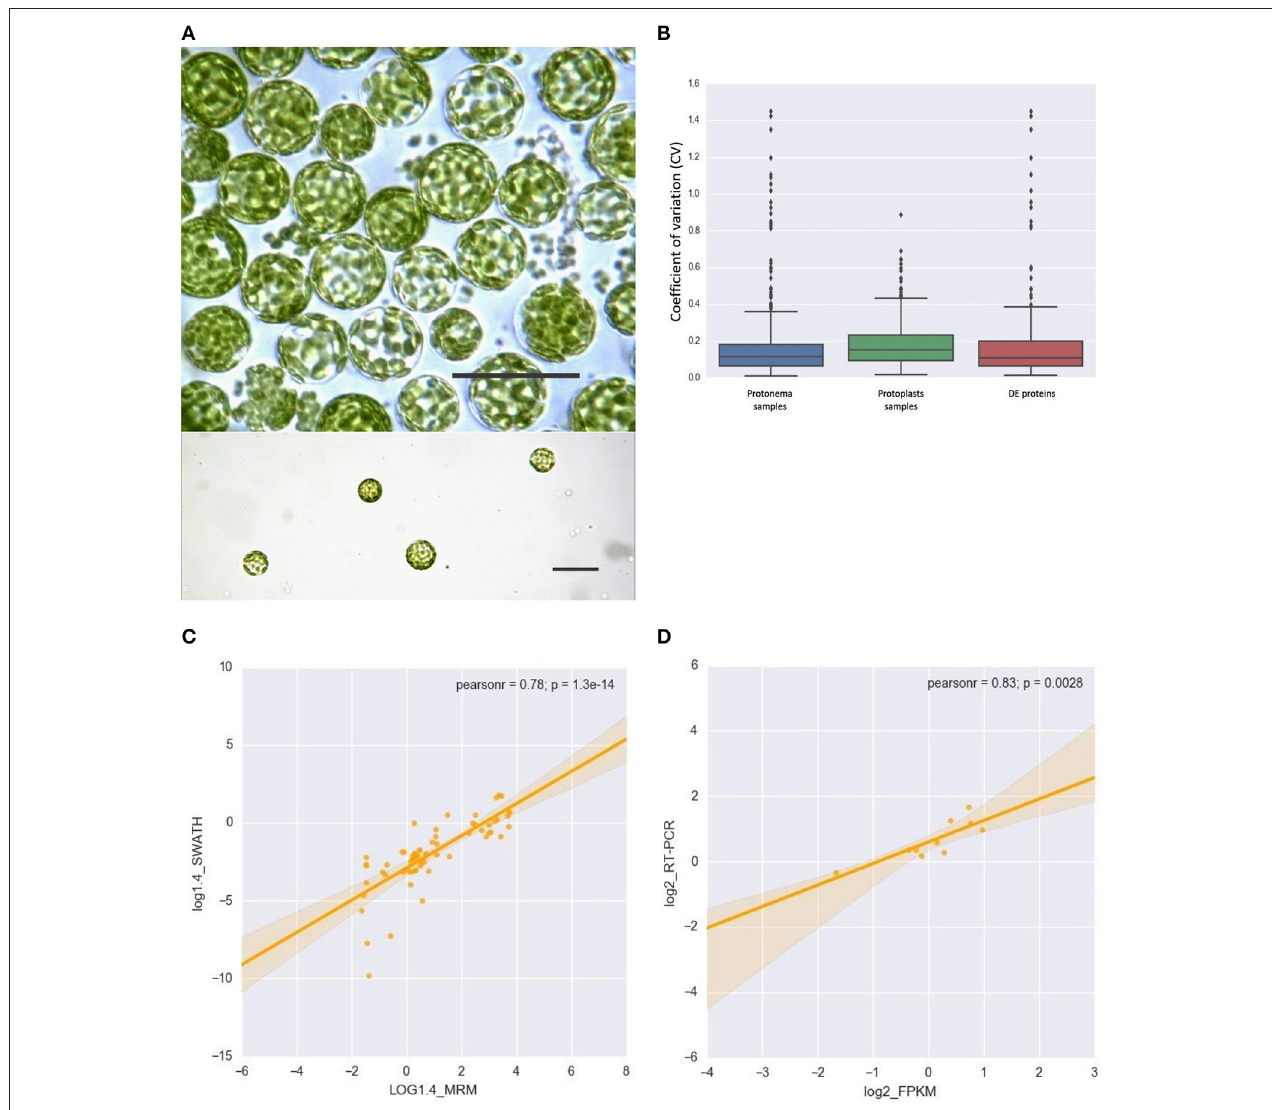
FIGURE 1 | (A) Light micrographs of protoplasts used in this study. Scale bars correspond to 50 µ m. (B) Box plot and 5–95 percentile whiskers illustrating the distribution of the coefficient of variation (CV) values of 503 SWATH-MS quantified proteins: protonema samples, protoplast samples, Differentially Accumulated proteins. The majority of proteins had a time course CV < 0.3. (C) The correlation analysis of the chloroplast proteins quantified by SWATH-MS and MRM-MS. The x-axis displays the protein fold changes quantified by MRM and the y-axis displays the protein fold changes quantified by SWATH. (D) Correlation of the fold change analyzed by RNA-Seq (x-axis) with the data obtained using real time PCR